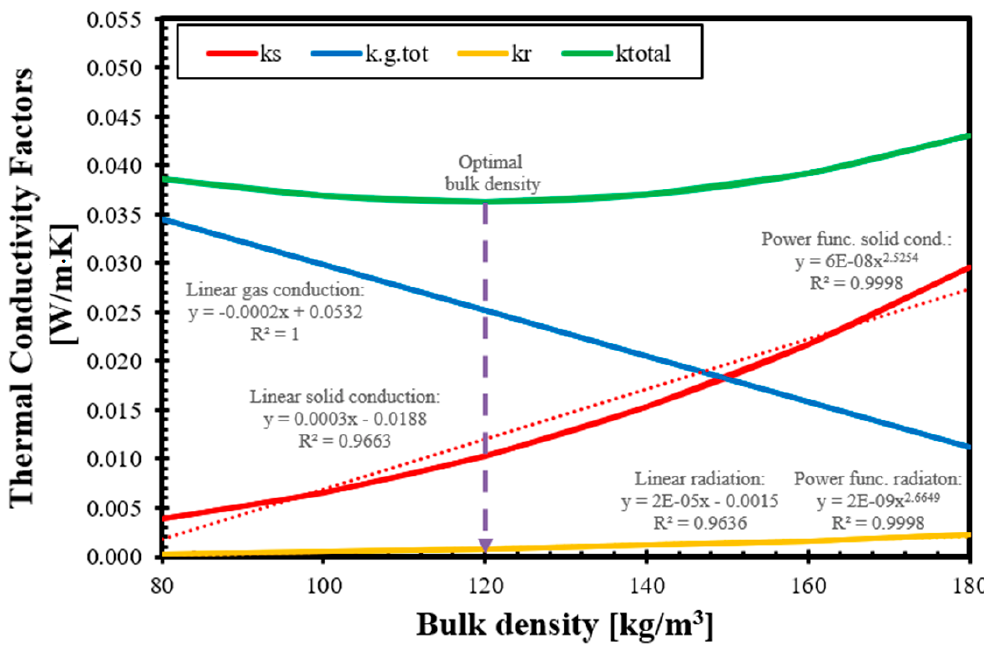
Figure 11. Thermal conductivity factors from the model in relation to the function of bulk density with added trend lines, regression equations, and R 2 ; Type-1 straw.